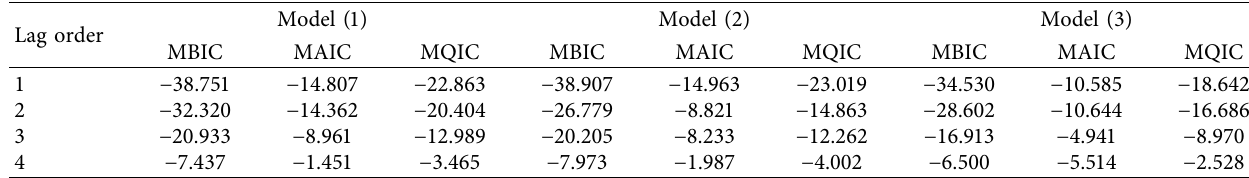
Table 3: The test results of MBIC, MAIC, and